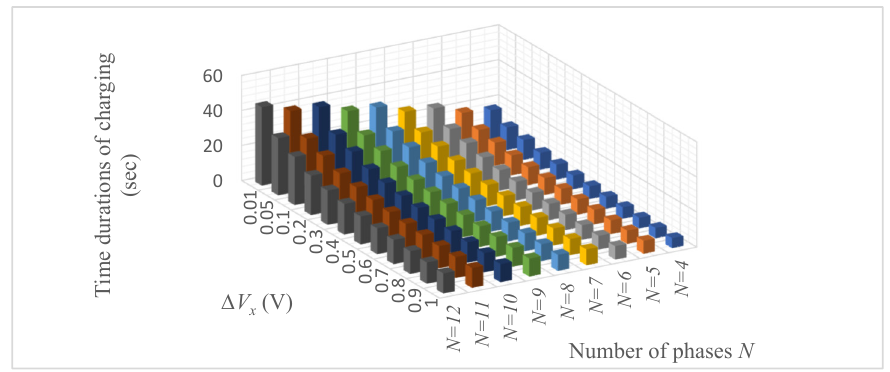
numbers of phases such as N = 4, N = 5, N = 6, and N = 7. The mutual current peak differ- Figure 20. SC circuit charging time durations at different ∆ V x for different numbers of phases. Figure 20. SC circuit charging time durations at different ∆ V ences for higher numbers of phases are less significant. x for different numbers of phases.